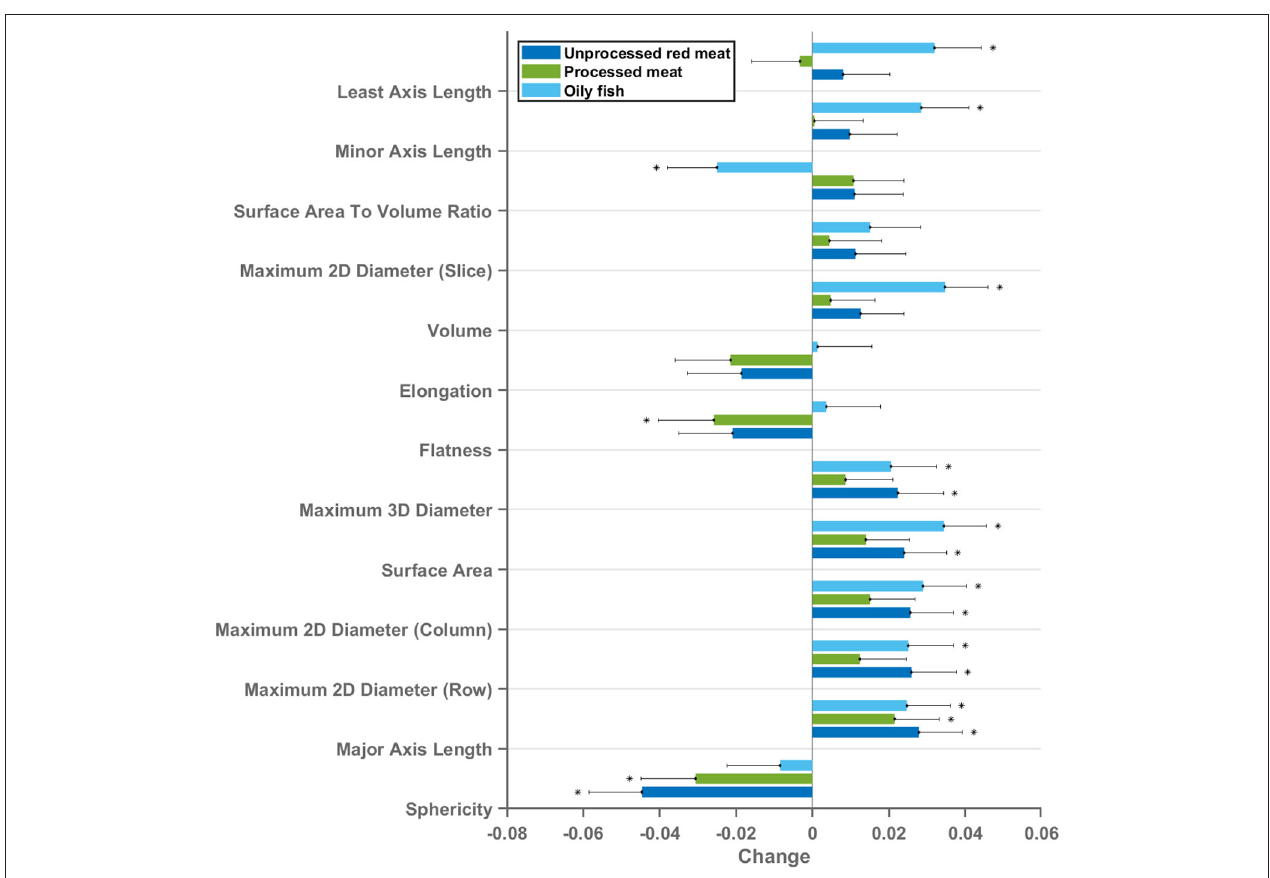
FIGURE 3 | Multivariable linear regression models showing change in LV cavity CMR shape radiomics (end-diastole) per 100g increase in daily meat consumption. Each bar represents standardised beta coefficients corresponding to the indicated radiomics shape feature. Each bar is from a separate model adjusted for age, sex, social deprivation, educational level, smoking, alcohol intake, and exercise level. Black lines represent half-length of confidence interval for the corresponding bar. Asterix denotes significant association. Bonferroni adjusted significance threshold p = 0.001 (corrected for 39 comparisons). CMR, cardiovascular magnetic resonance; LV, left